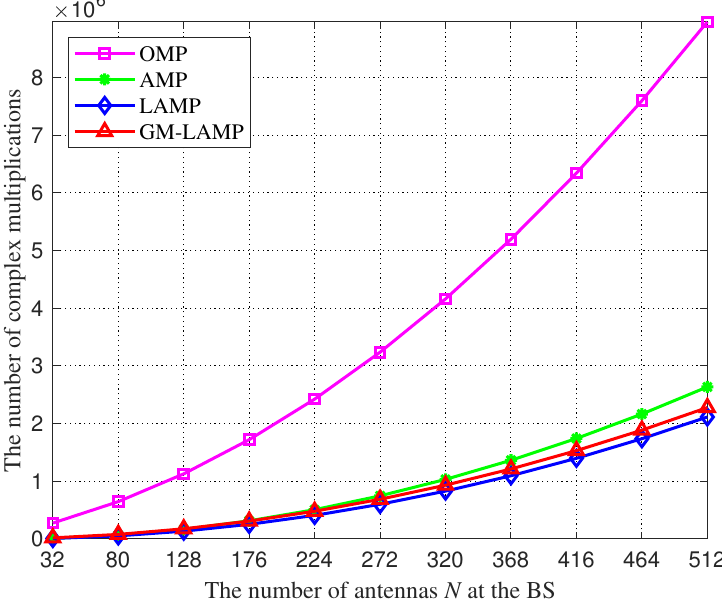
Figure 3. The number of complex multiplications against the number of antennas N . Figure 5 plots the variation of estimation error in low-resolution ADCs from one to four bits and mixed resolution after adopting the GAMP network scheme. The sparsity in this figure is equivalent to the number of channel paths ( L k ). With the increase in